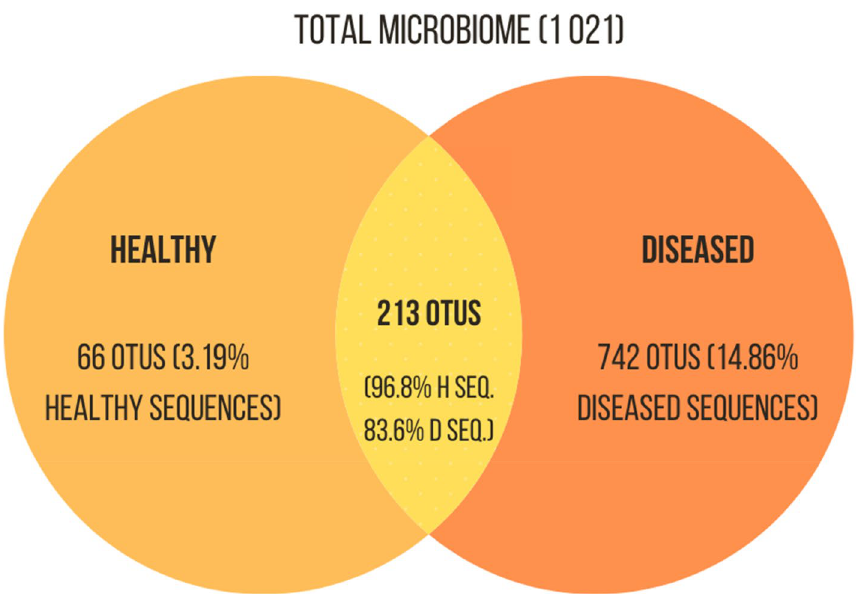
Figure 2. Venn Diagram indicating the number of OTUs of Bacteria associated with Tubastraea tagusensis . The microbiota exclusive to healthy colonies is represented in light orange, whereas the microbiota of diseased colonies is represented in dark orange. The intersection, yellow, indicates the microbiota shared by both